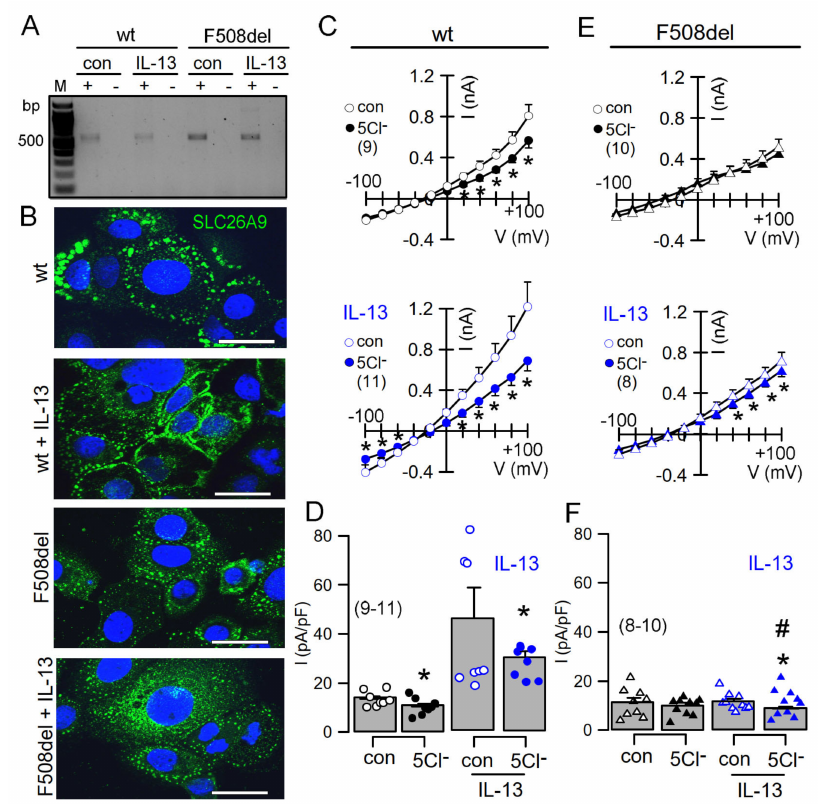
Figure 6. IL-13 augments membrane expression of SLC26A9 and induces basal currents in CFBE airway epithelial cells expressing wtCFTR but not in cells expressing F508del-CFTR. ( A ) Expression of SLC26A9 detected by RT-PCR in CFBE airway epithelial cells stably expressing wtCFTR (wt) or F508delCFTR (F508del). Cells were treated with IL-13 (20 ng/72 h), which did not enhance expression of SLC26A9. ( B ) Immunohistochemistry of SLC26A9 in CFBE/wtCFTR and CFBE/F508delCFTR cells. Exposure of the cells to IL-13 enhanced membrane expression of endogenous SLC26A9 in cells expressing wtCFTR, but not in cells expressing F508del-CFTR. Note that in CFBE/wtCFTR cells, some SLC26A9 is located in the plasma membrane even in the absence of IL-13, whereas CFBE/F508del cells show cytoplasmic expression of SLC26A9. Bars = 20 µ m. ( C – F ) Current/voltage relationships showing basal currents in CFBE/wtCFTR ( C , D ) and CFBE/F508delCFTR ( E , F ) cells in the absence or presence of IL-13, as well as the effect of removal of chloride (5Cl − ) from the extracellular bath solution. Basal Cl − transport detected by 5Cl − replacement was larger in CFBE/wtCFTR cells when compared to CFBE/F508del cells. Mean ± SEM (number of cells). * Significant inhibition by 5Cl − ( p < 0.05; paired t -test). # Significant difference compared to wtCFTR ( p < 0.05; unpaired t